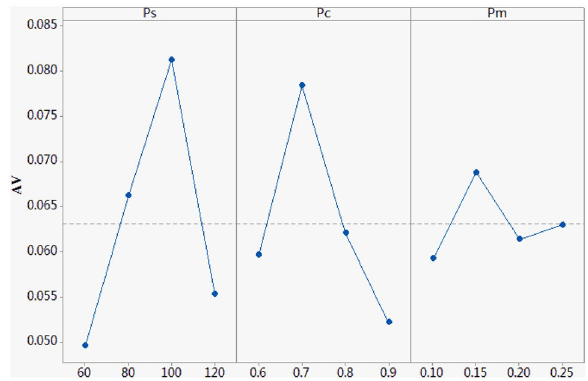
Figure 13. Factor level trend.